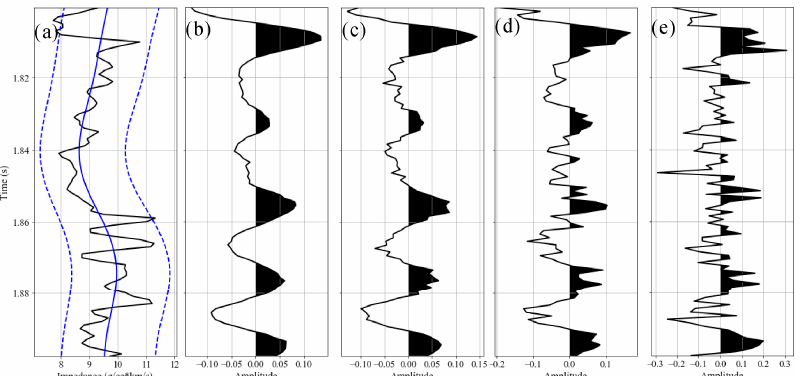
Figure 2. Synthetic impedance model (black solid line in ( a )), prior impedance model (blue solid line in ( a )), 0.95 prior model interval (blue dotted lines in ( a )) and seismic data with different noise levels (from ( b – e ) with variances of 10 − 5 , 10 − 4 , 10 − 3 , and 10 − 2 , respectively).